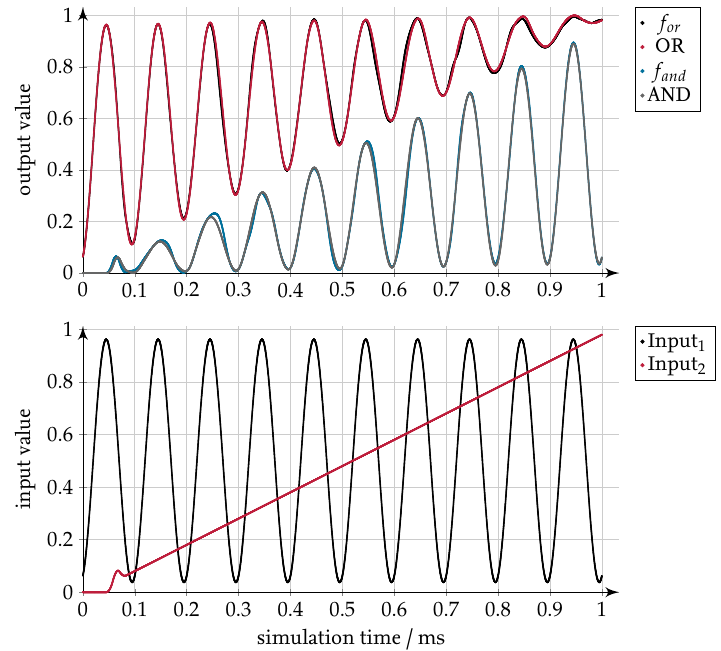
Figure 14. Results from the testbench for the logic operations OR and AND and corresponding operations f or = x 1 + x 2